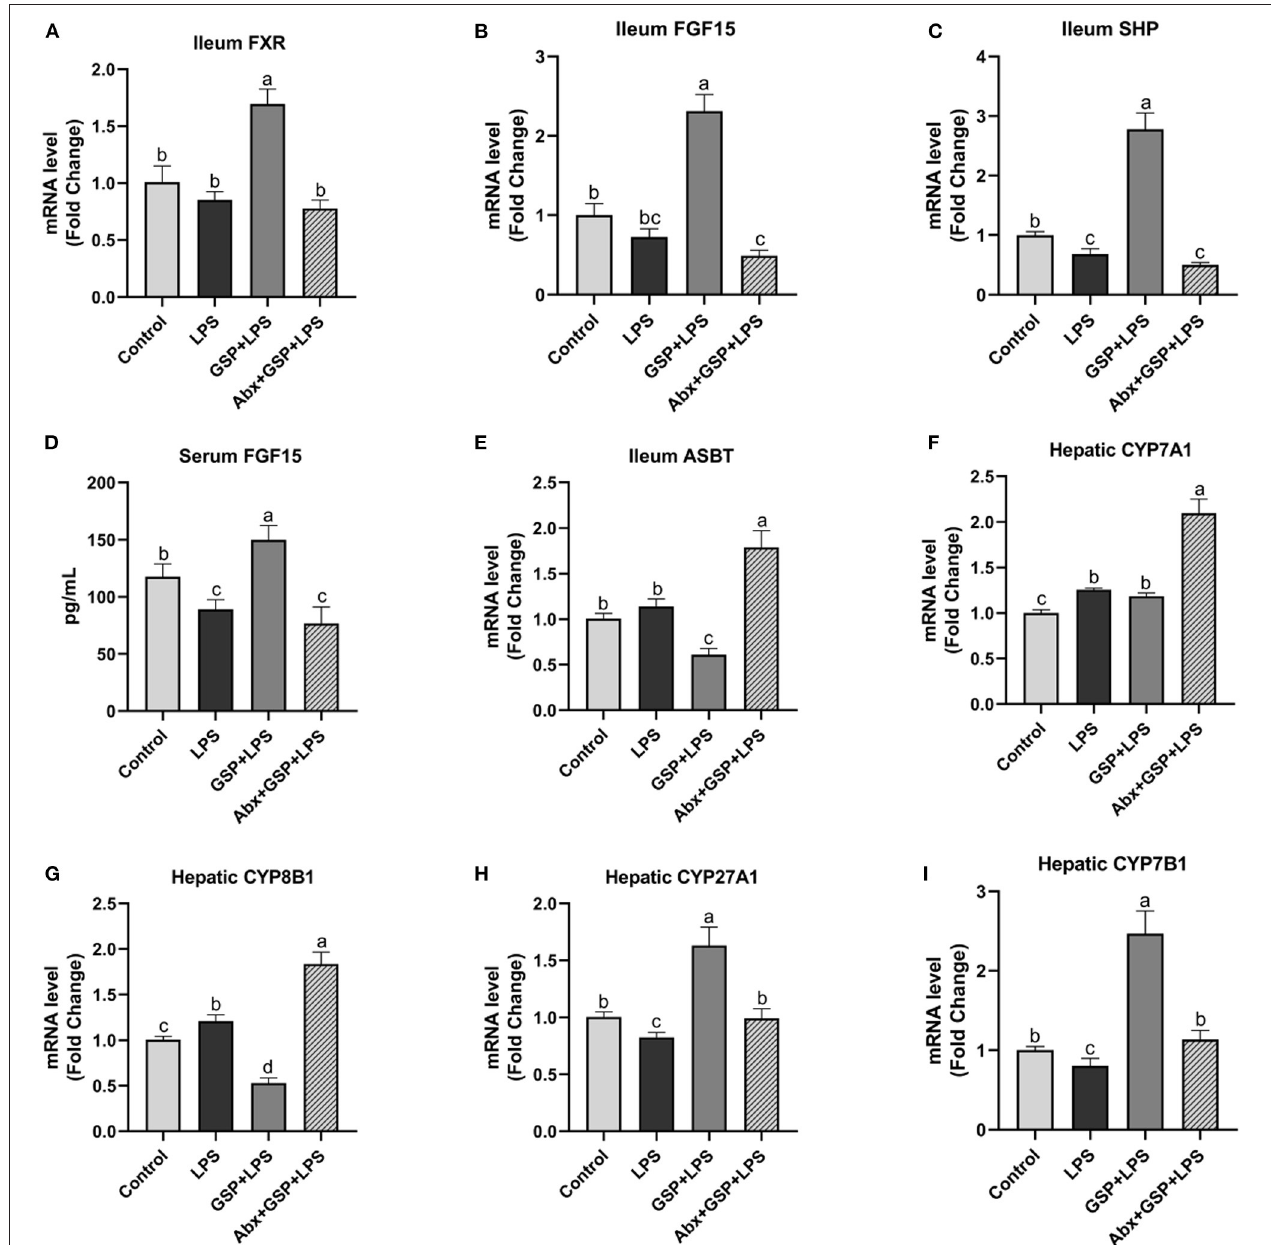
FIGURE 4 | The intestinal farnesol X receptor (FXR) activity and the expression of genes involved in bile acid recirculation in C57BL/6 mice with different treatments in experiment 1. (A,B) Gene expression levels of FXR and fibroblast growth factor 15 (FGF15) in the ileum. (C) Gene expression level of SHPs in the ileum. (D) Serum FGF15. (E) Gene expression level of apical sodium-dependent BA transporter (ASBT) in the distal ileum. (F–I) Gene expression levels of cytochrome P450 7A1 (CYP7A1), CYP8B1, CYP27A1, and CYP7B1 in the liver. Control, control group that oral gavaged with physiological saline before i.p. PBS injection; LPS, a LPS injection group that oral gavaged with physiological saline before i.p. LPS injection; GSP + LPS, a GSP administration group that oral gavaged with 250 mg/kg GSP before i.p. LPS injection; Abx + GSP + LPS, an antibiotic group that given a mixture of antibiotics in drinking water before the experiment 1, and then coupled with GSP before i.p. LPS injection. Data are presented by the mean ± SEMs ( n = 6). Bars with no letter in common are significantly different, p ≤